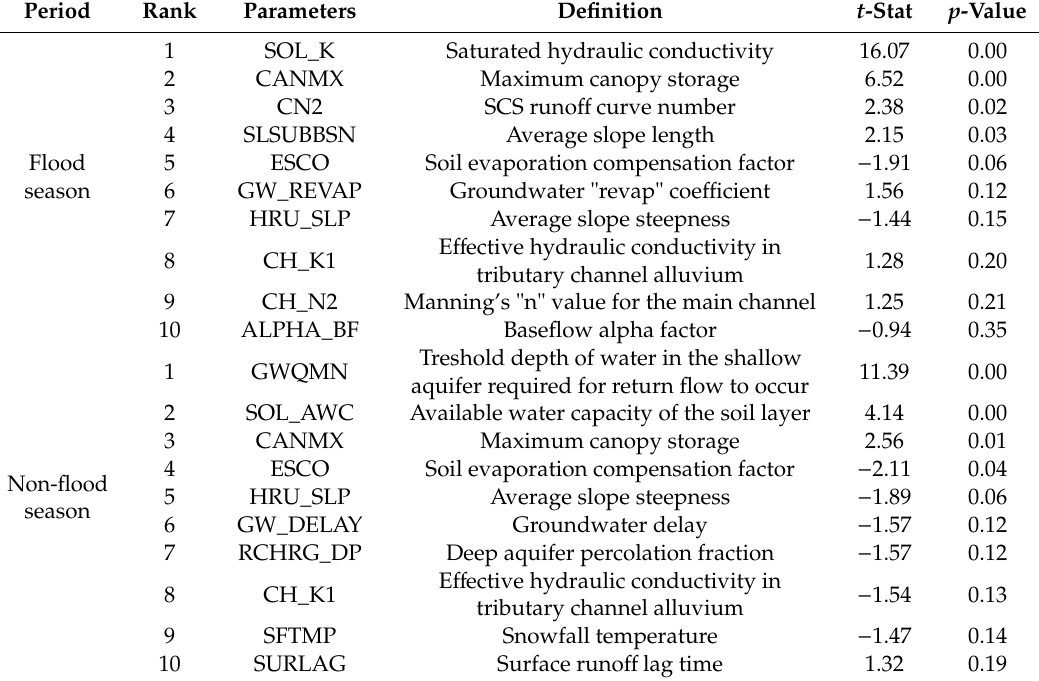
Table 1. The sort of the sensitive